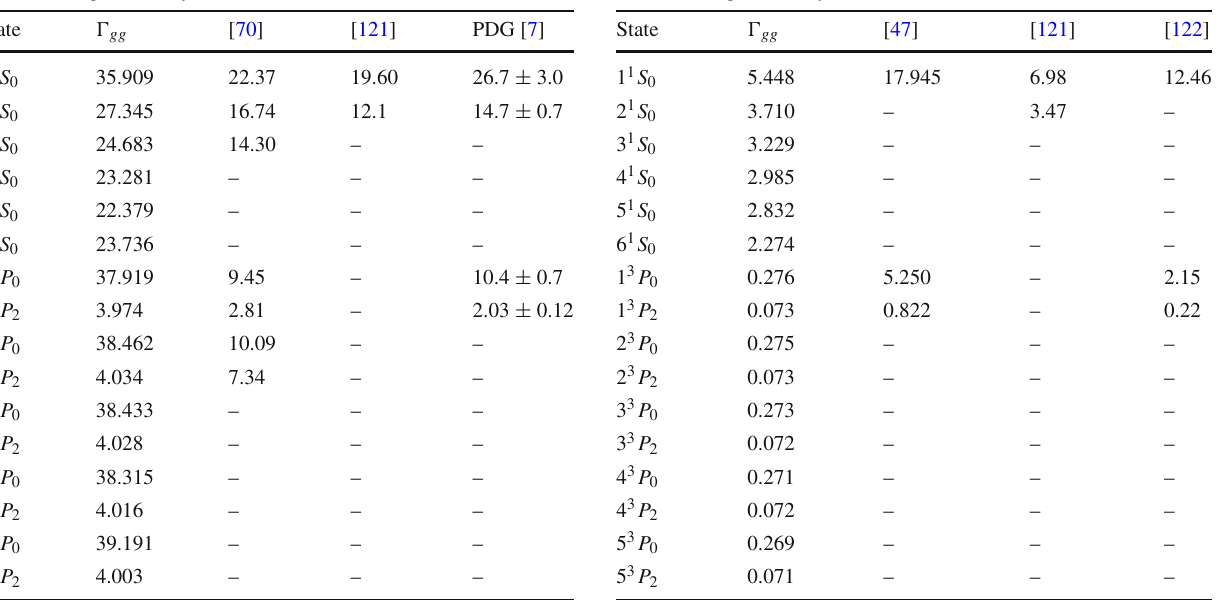
Table 16 Digluon decay width of S and P -wave charmonia (in MeV) Table 17 Digluon decay width of S and P -wave bottomonia (in MeV)